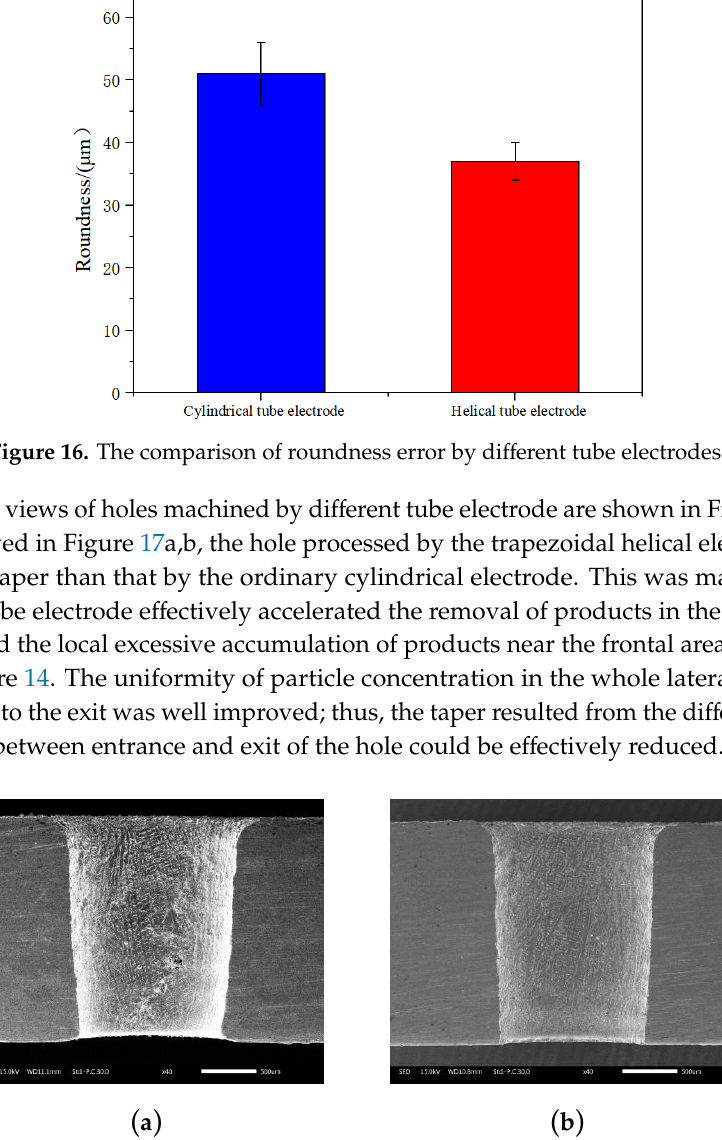
Figure 17. Sectional views of holes machined by different tube electrodes: ( a ) Cylindrical tube electrode; ( b ) helical tube electrode.